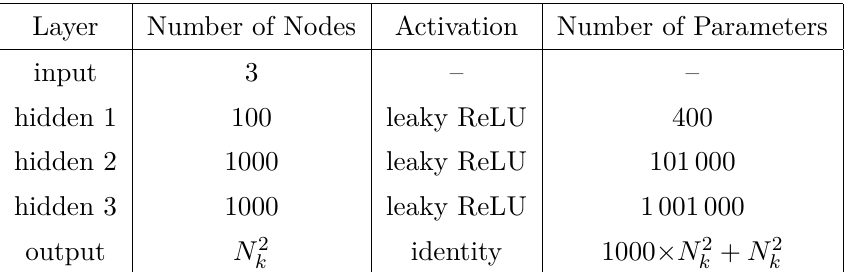
Table 1 . Neural network architecture for the neural network that learns the ψ -dependence of H .